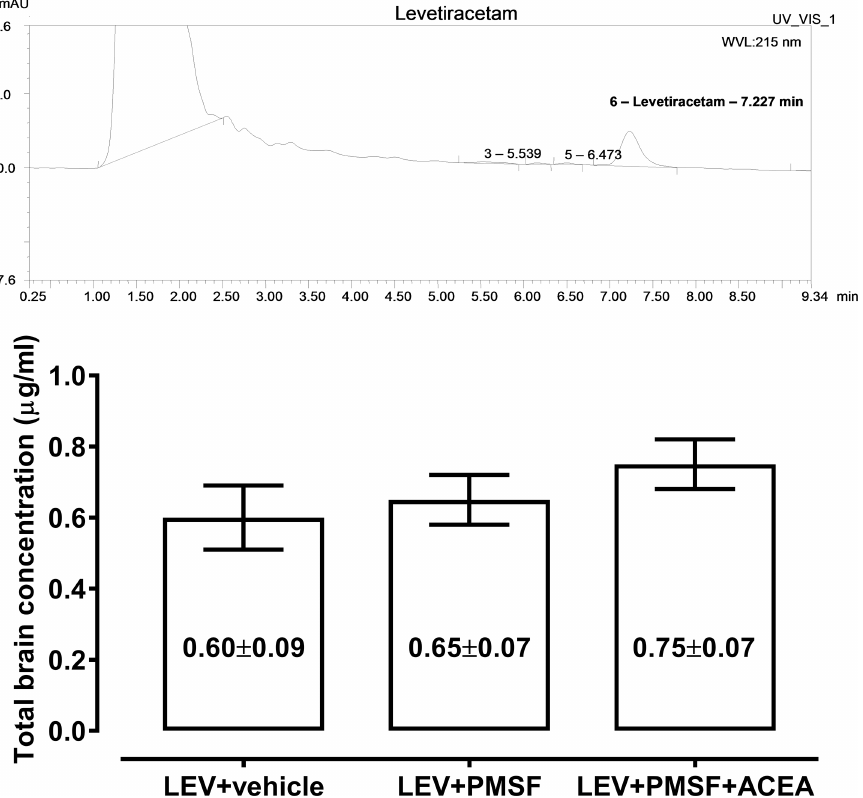
Fig 2. Influence of ACEA and PMSF on total brain concentrations of levetiracetam (LEV) in mice. Columnsrepresent total brain concentrations (means in μ g/ml ± S.E.M.) of LEV (n = 8 mice/column). Data were statistically analyzedwith one-wayANOVA. Brain tissue samples were taken at times scheduledfor the 6-Hz corneal stimulationmodel.